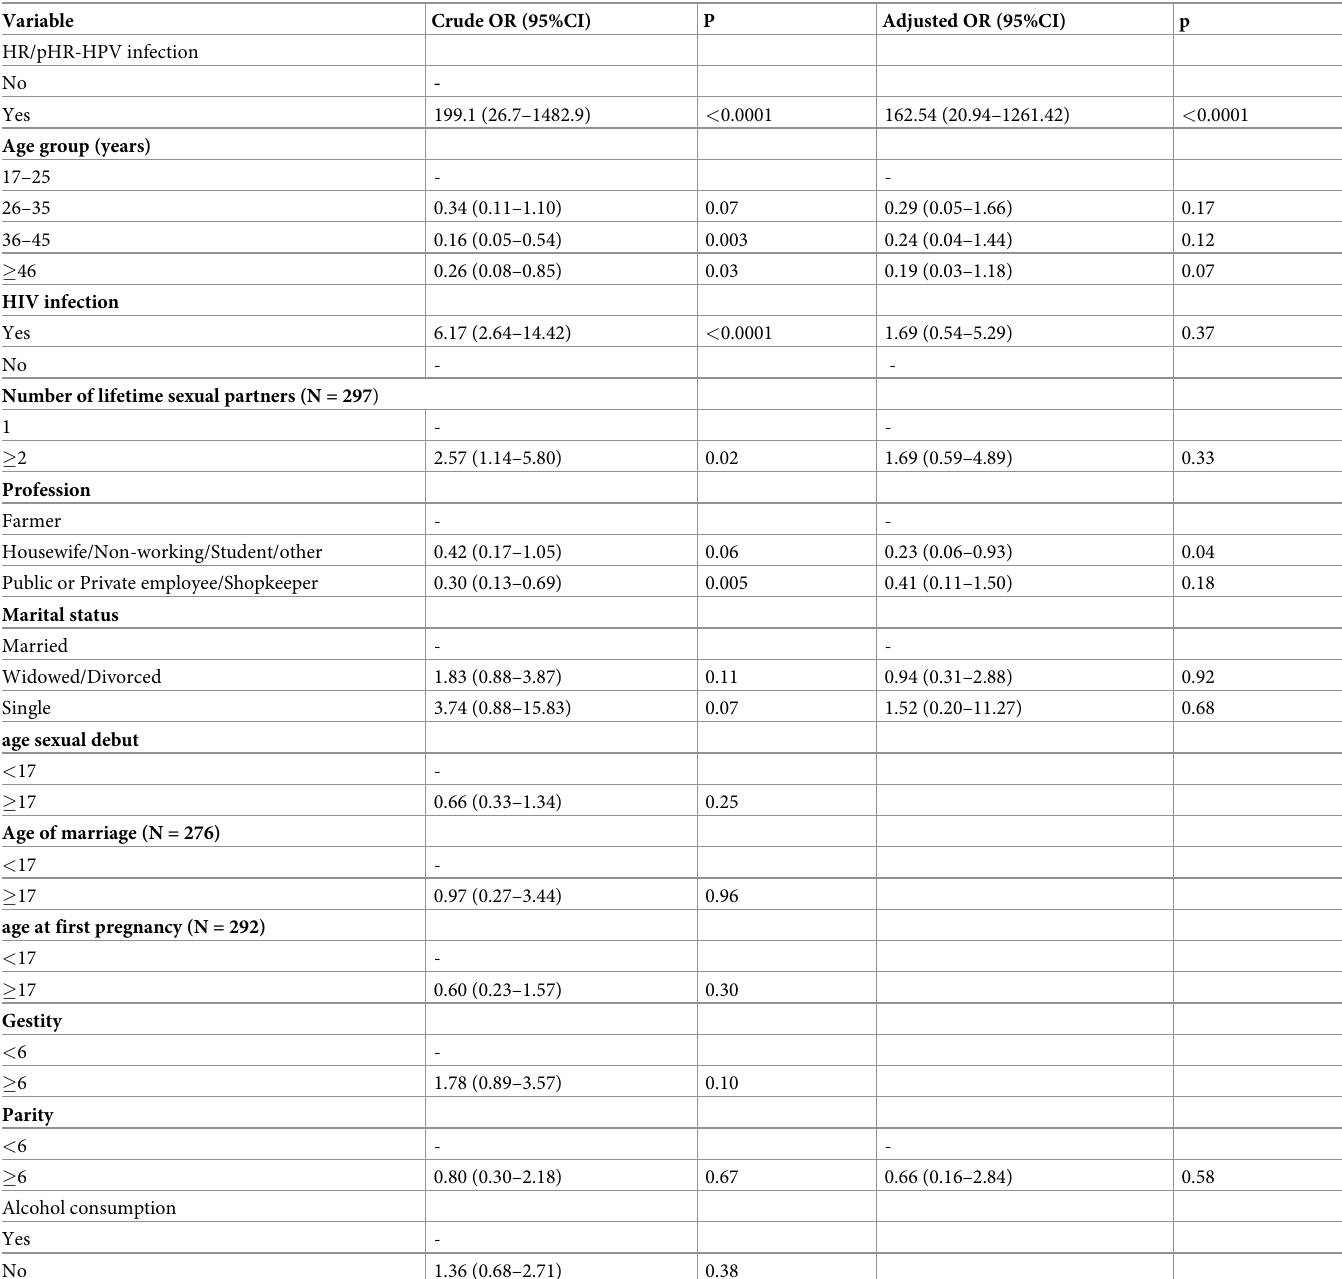
Table 3. Predictors of abnormal cytological results (ASCUS +) in urban women.